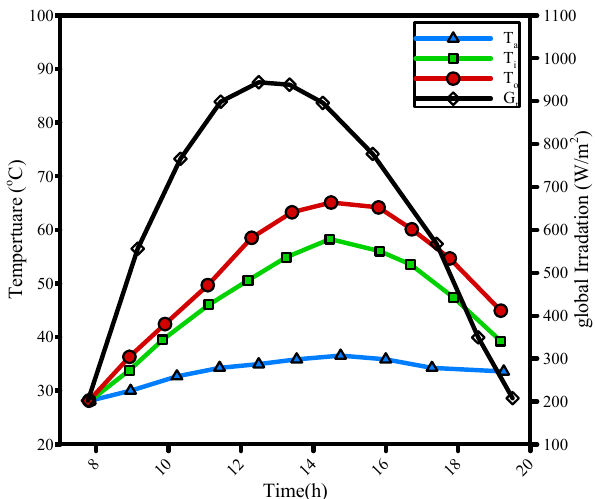
Figure 10. The experimental curves for temperatures and global irradiance for 1 day.